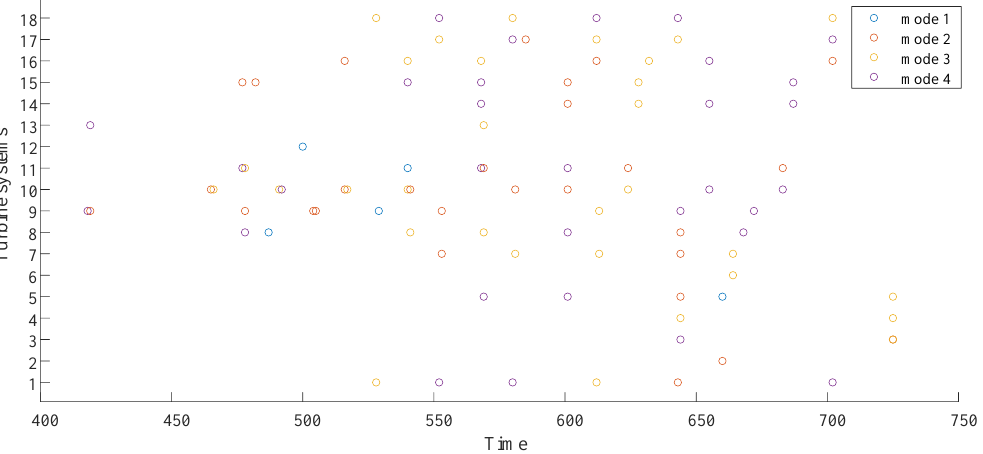
Figure 7. The dynamic grouping failure modes of 18 turbine systems .